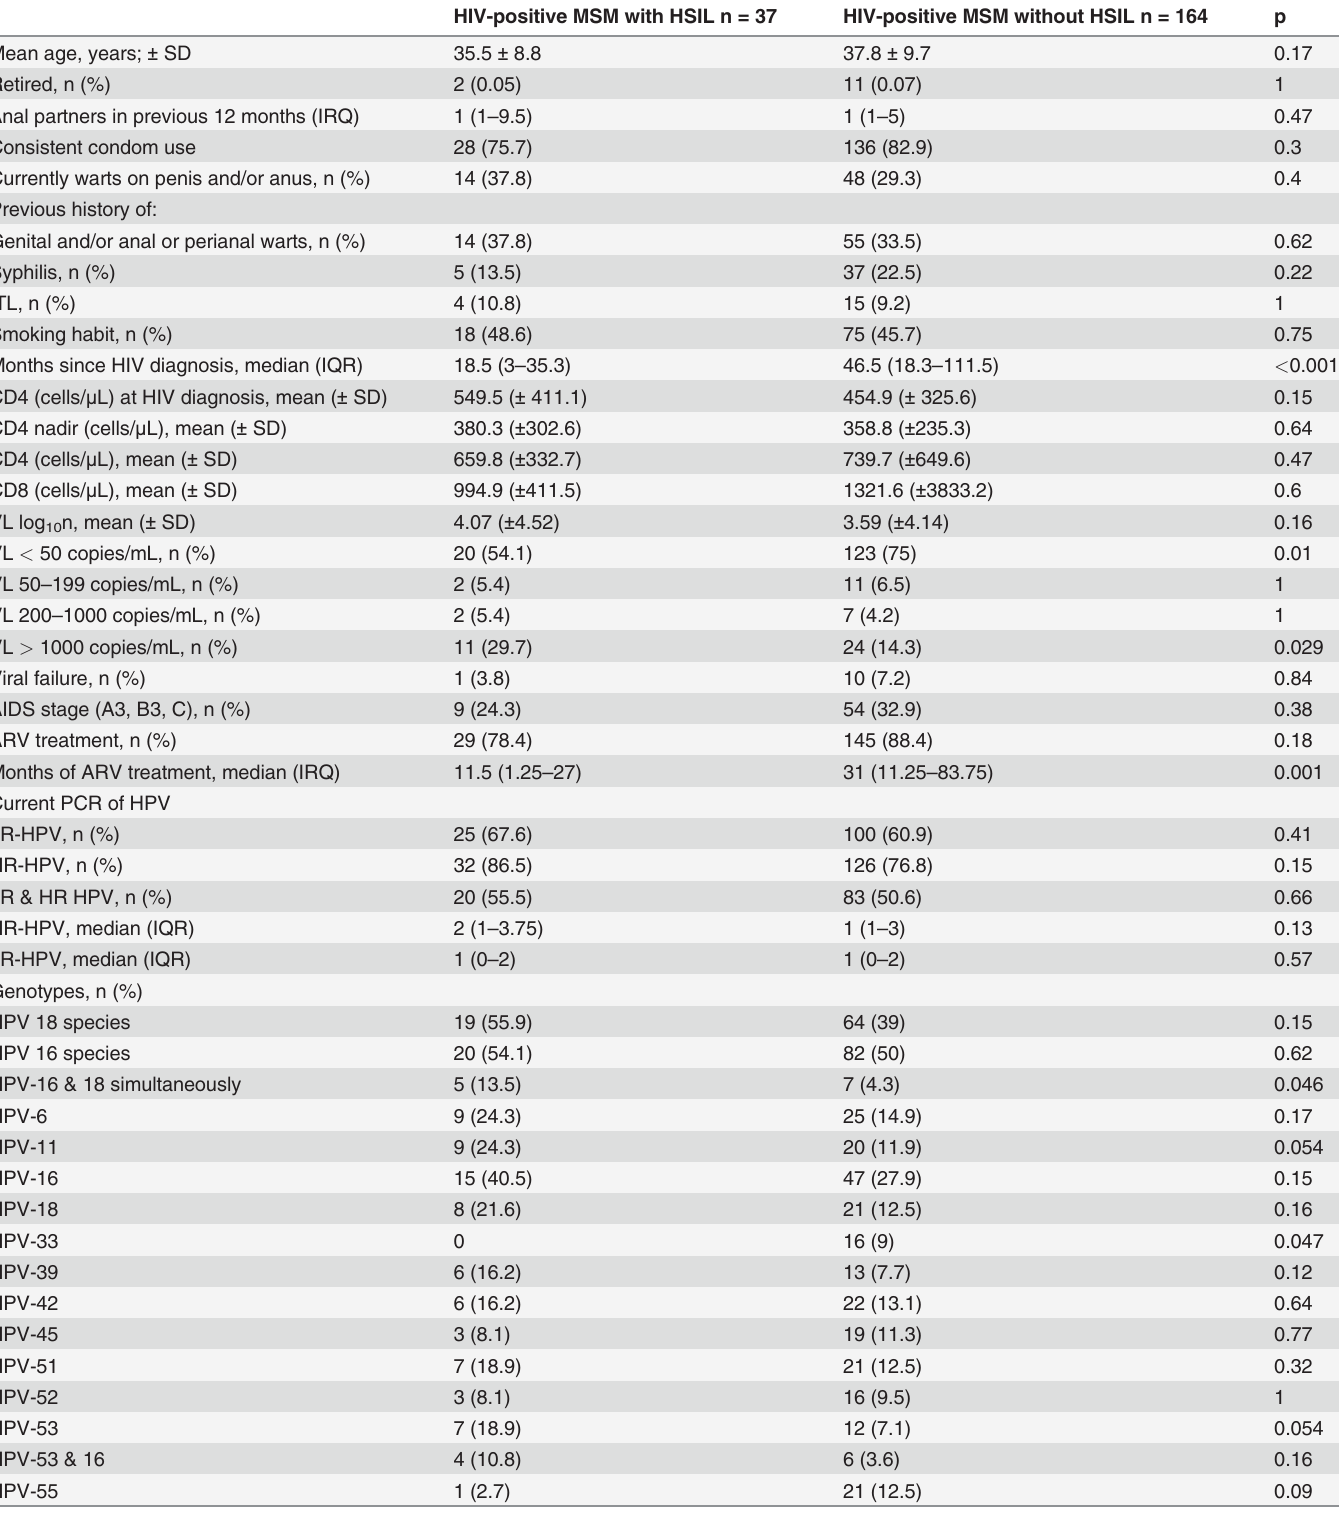
Table 5. Risk factors associated with the appearance of HSIL in anoscopy. Results of univariate